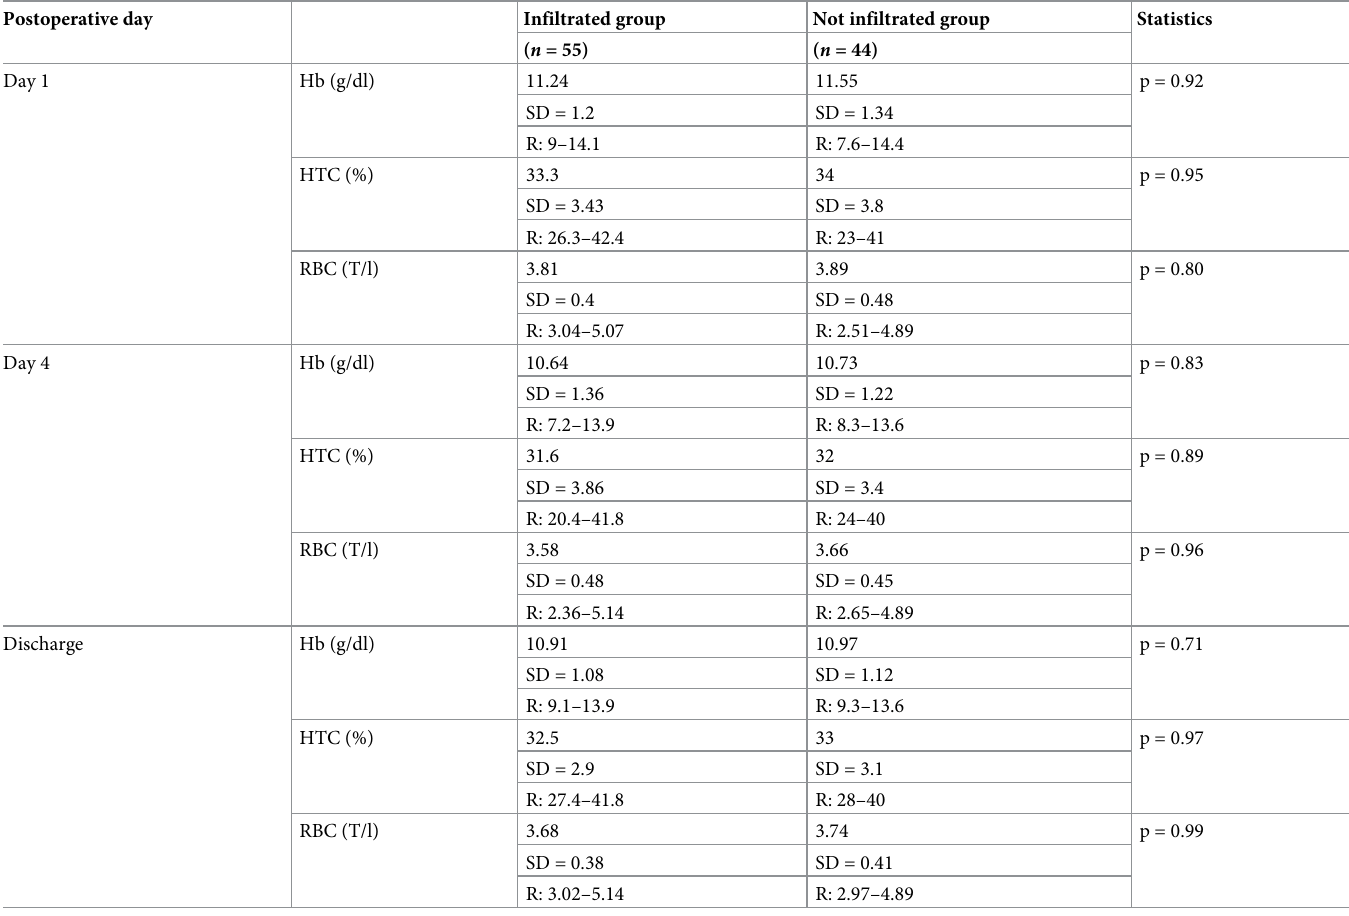
Table 3. The comparison of postoperative hemoglobin levels (Hb), hematocrit (HTC) and red blood count (RBC). Postoperative